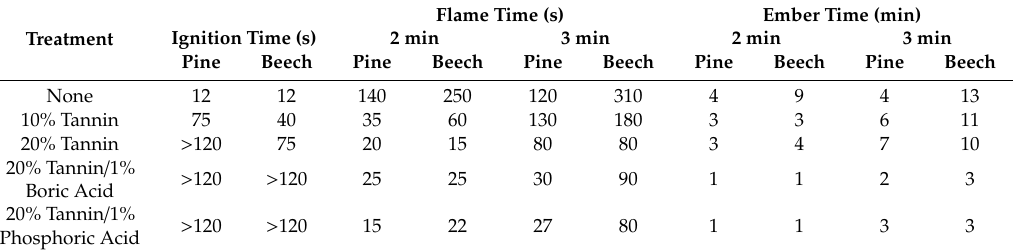
Table 10. Pine and beech flame exposure results [85].